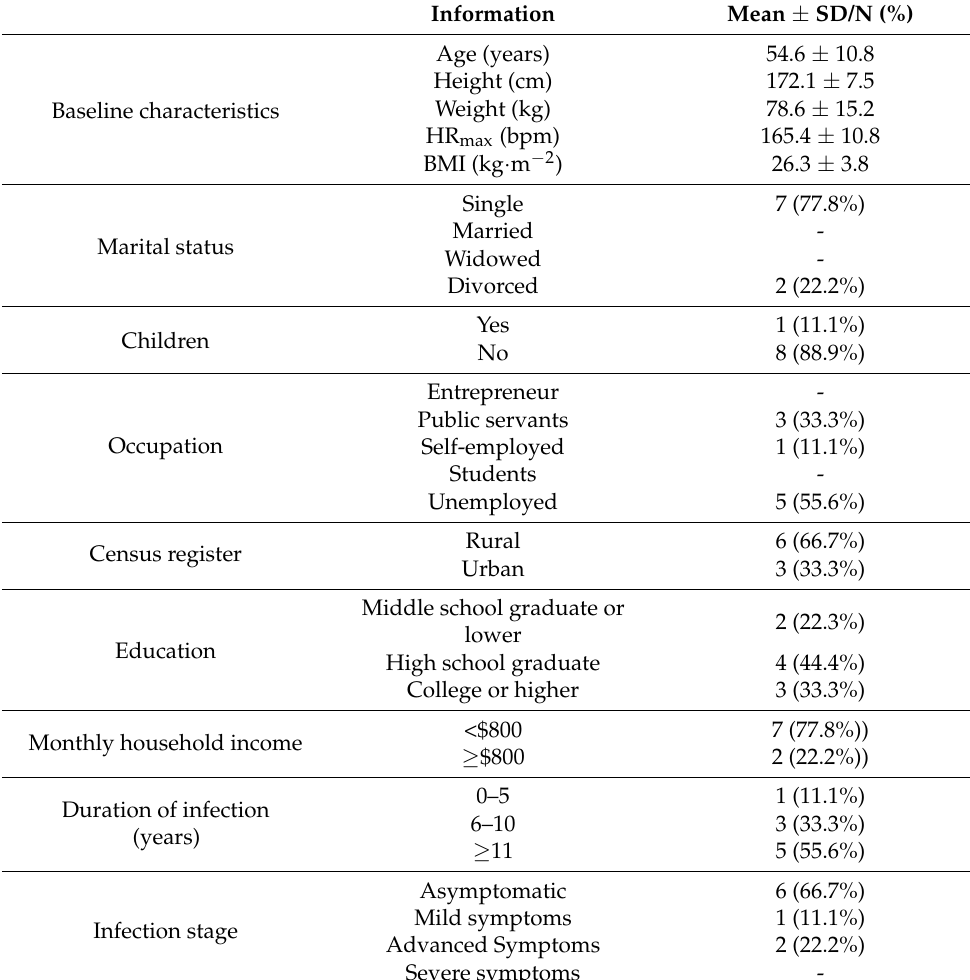
Table 1. Individual characteristics of the whole study group (N =